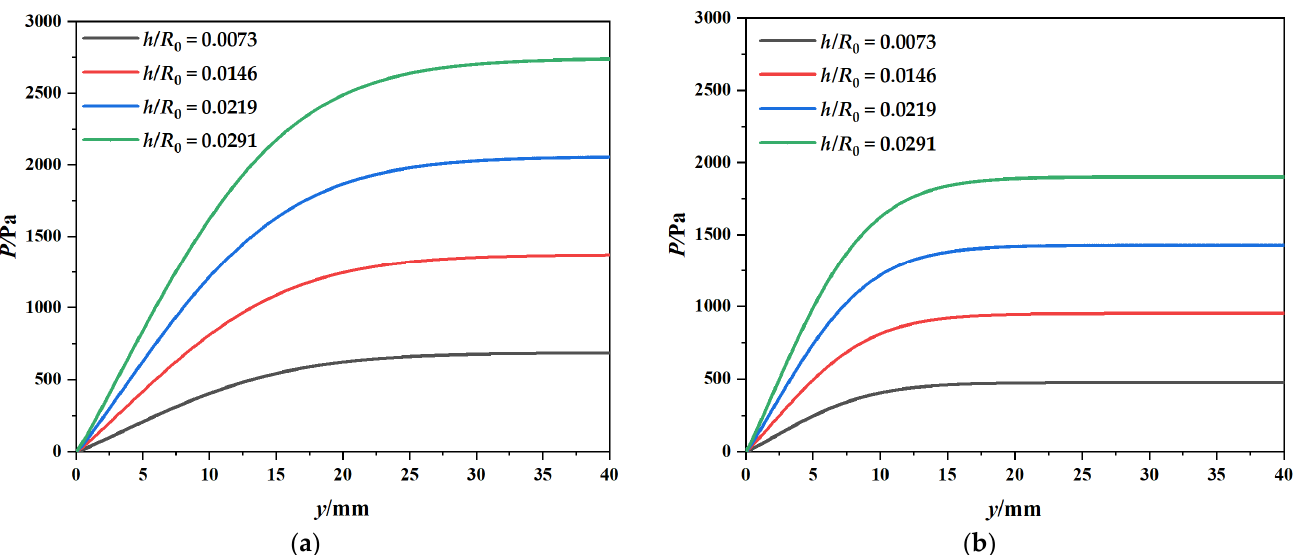
Figure 11. Velocity distribution with different h/R 0 over logarithmic spiral wall surfaces at ( a ) x / R = 1 and ( b ) x / R = 2/3.